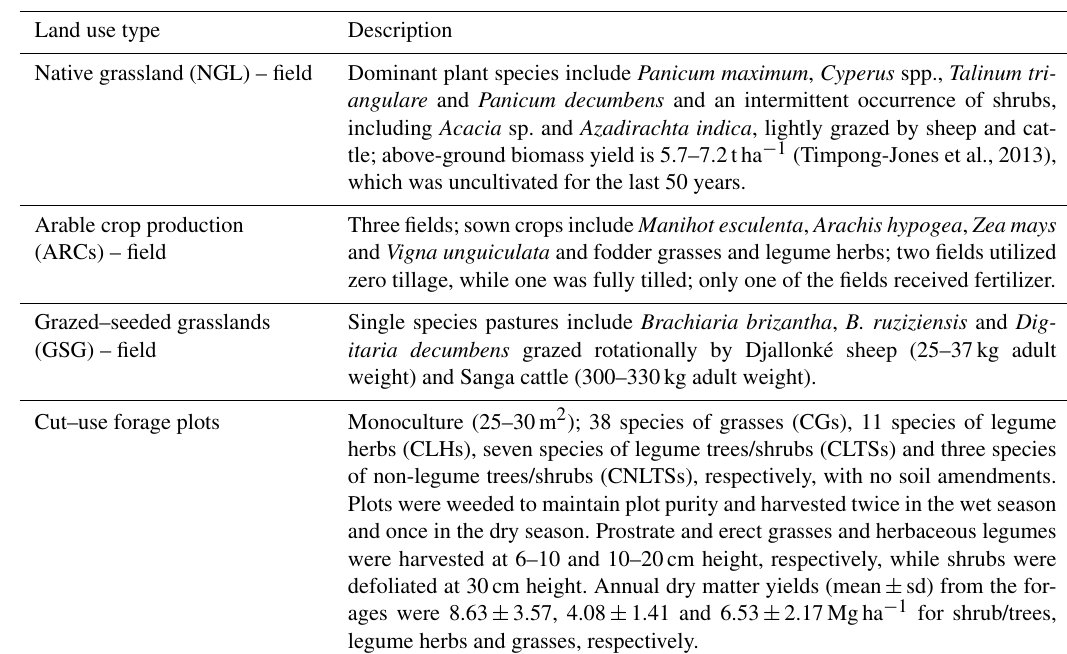
Table 1. Brief description of land use types at the study site. Land use